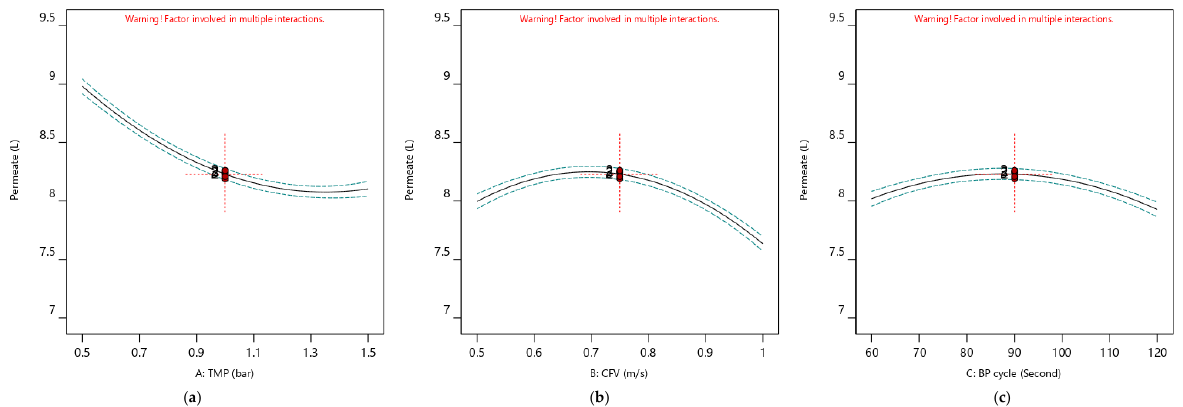
Figure 5. All independent factors (TMP, CFV, and Pulsatile cycle) perturbation for membrane permeate volume considering one factor at time impact. (All design points are at 95% CI bands). ( a ) B: CFV = 0.75 m/s and C: BP cycle = 90 s. ( b ) A: TMP = 1 bar and C: BP cycle = 90 s. ( c ) B: CFV = 0.75 m/s and A: TMP = 1 bar.